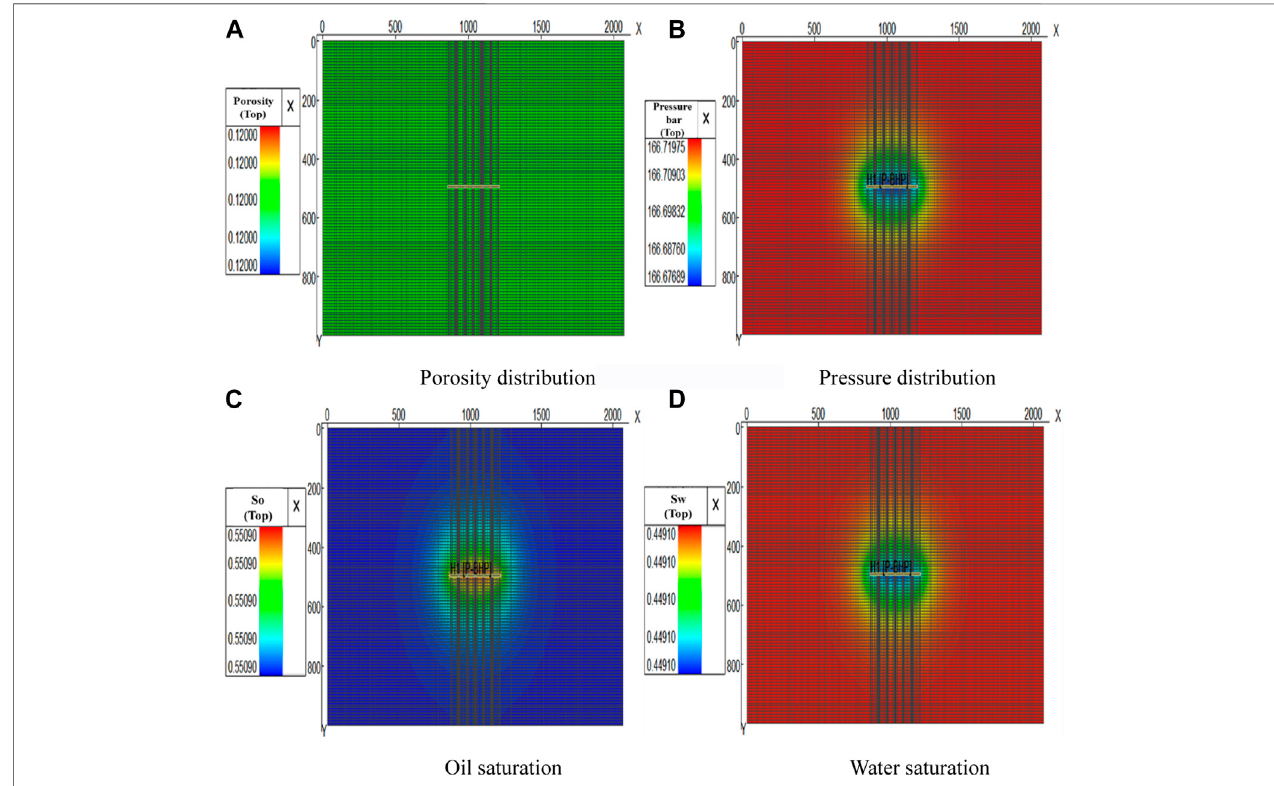
FIGURE 5 | The grid model of the numerical simulation model. (A) Porosity distribution. (B) Pressure distribution. (C) Oil saturation. (D) Water saturation.